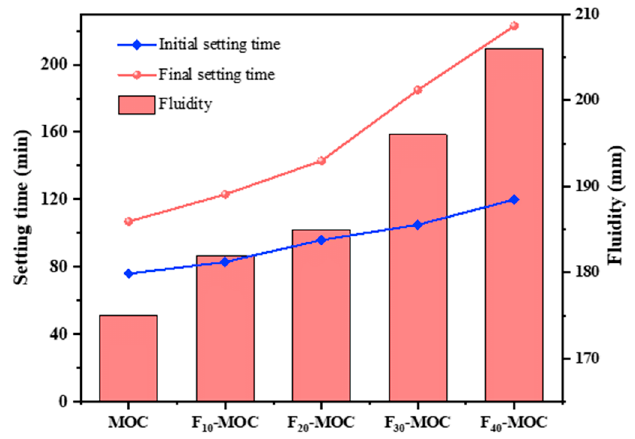
Figure 2. Fluidity and setting time of MOC mixed with fly ash.